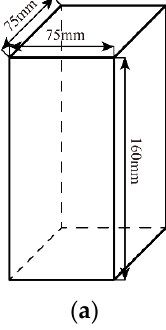
Figure 5. Specimen preparation: ( a ) schematic of the specimen; ( b ) photograph of speckle pattern on membrane; ( c ) schematic of sampling points used for SEM tests.